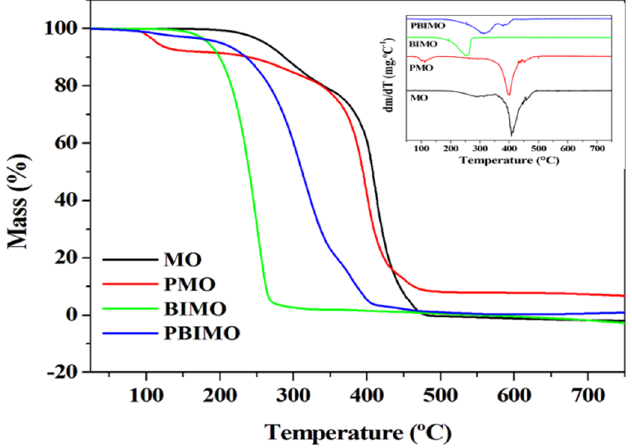
Figure 4. TG and DTG curves of MO, PMO, BIMO, and PBIMO, acquired at a heating rate of 10 °C·min − 1